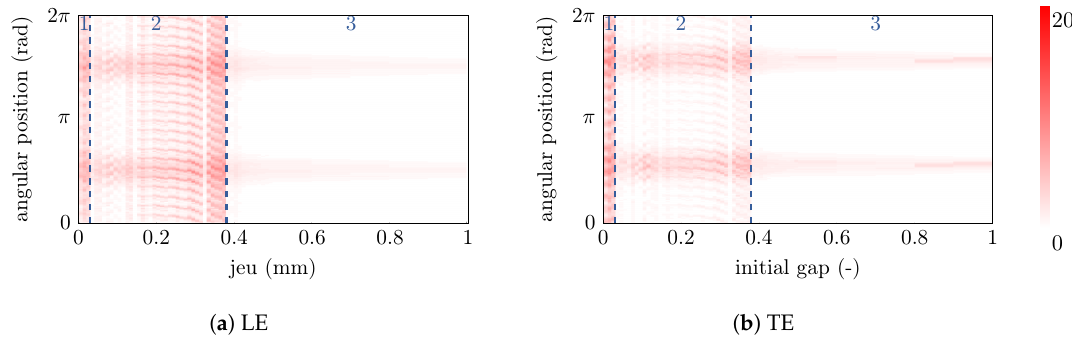
Figure 23. Evolution of the temperature profile with the initial clearance for the HP compressor